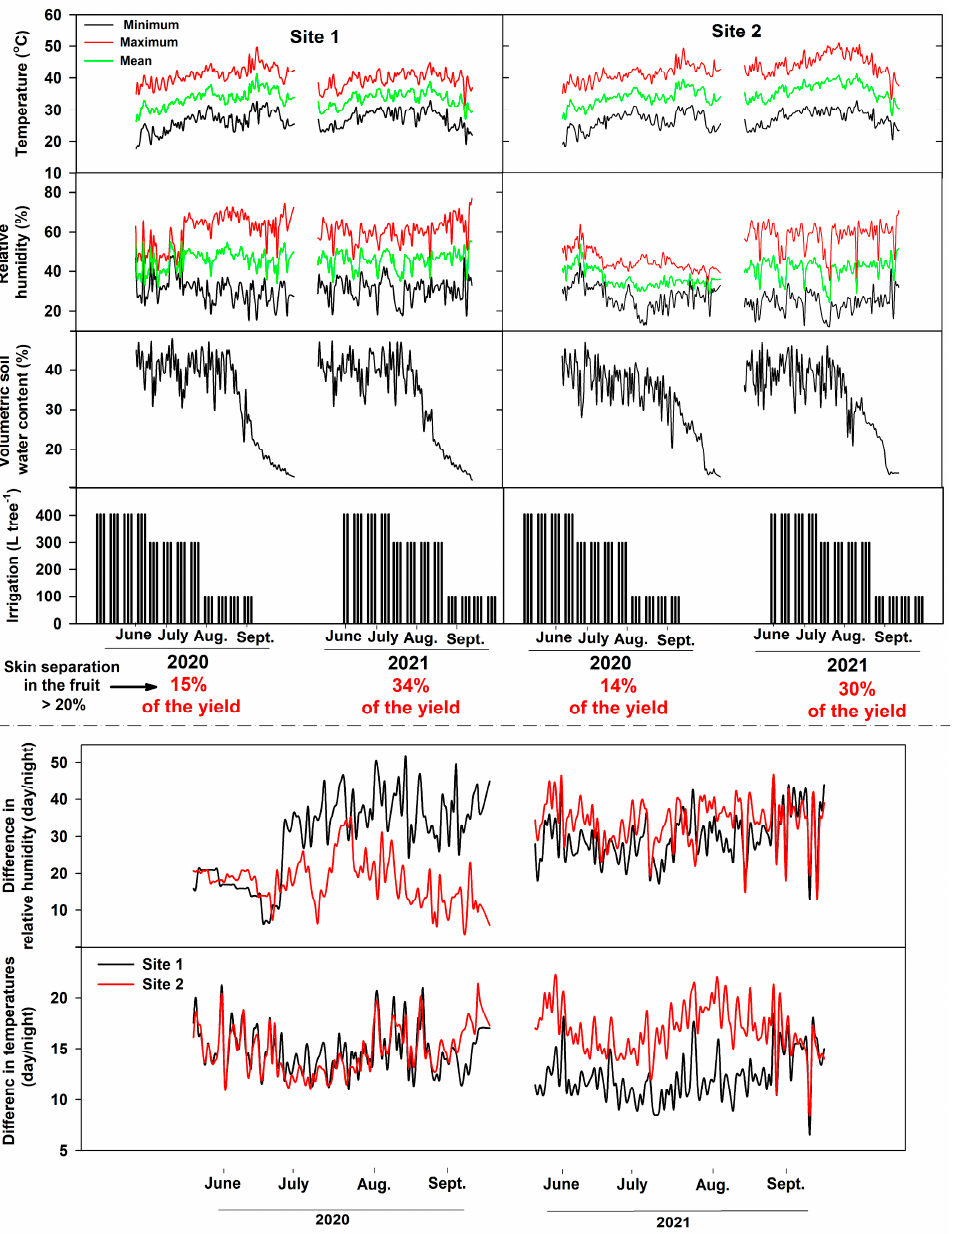
Figure 4. Weather macroclimate, irrigation per tree, and volumetric soil water content during the study period in both sites at the Medjool Village, Jordan Valley, Jordan.